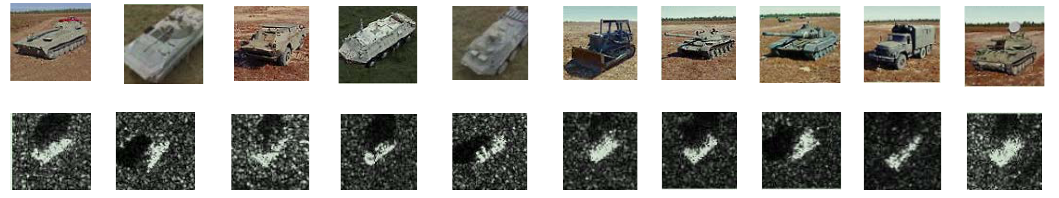
Figure 5. SAR Images Instance in MSTAR Dataset. Table 2. The training and test datasets.